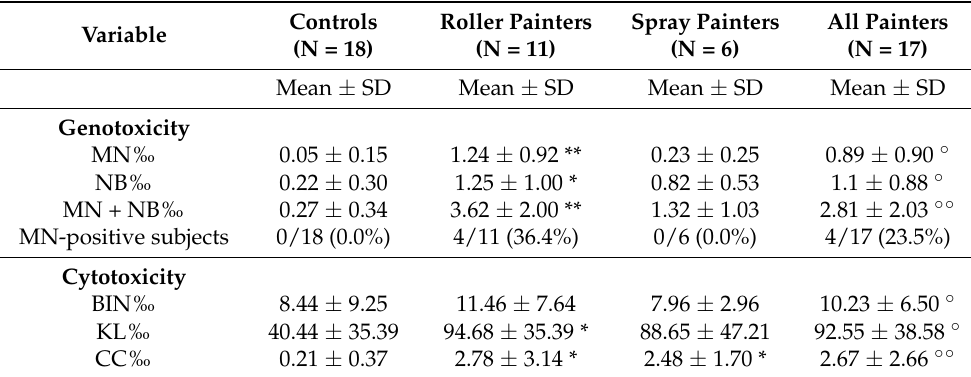
Table 2. Buccal micronucleus cytome assay